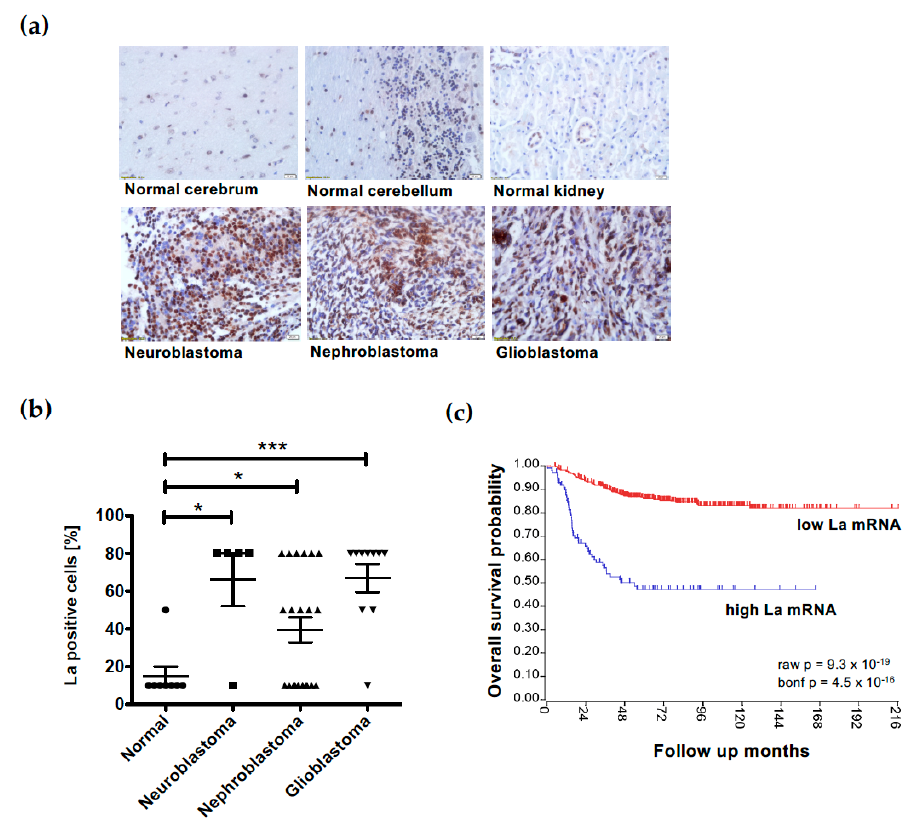
Figure 9. High expression of the RNA-binding protein La correlates with low overall survival probability in neuroblastoma. ( a , b ) Immunohistochemical analysis of tissue microarray TMA MC809 demonstrates significant overexpression of the La protein in neuroblastoma, nephroblastoma and glioblastoma tissue compared to normal cerebrum, cerebellum and kidney tissue. ( c ) Kaplan–Meier curve indicating that elevated expression of La mRNA is an indicator for reduced overall survival probability in neuroblastoma. The neuroblastoma data set SEQC-498 consists of 498 cases including 398 patient samples with low (red) La and 100 with high (blue) La mRNA expression levels, leading to a signi fi cant di ff erence. The datasets for the Kaplan – Meier curves were retrieved from the R2 platform (h tt ps://r2.amc.nl, dataset ID: GSE62564, accessed on 9 March 2023). Degrees of signi fi cance (unpaired student’s t-test): * < 0.05, ** < 0.01 and *** < 0.001.